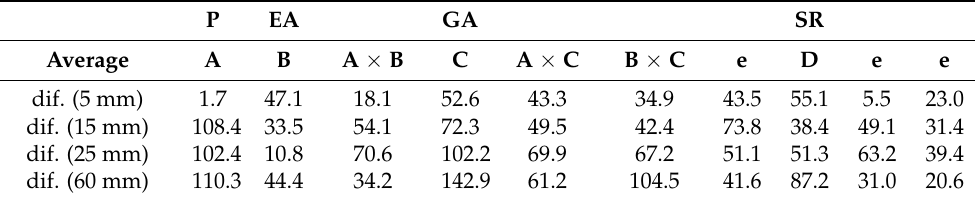
Table 9. Analysis of the relative contribution of the parameters on the mean temperature.